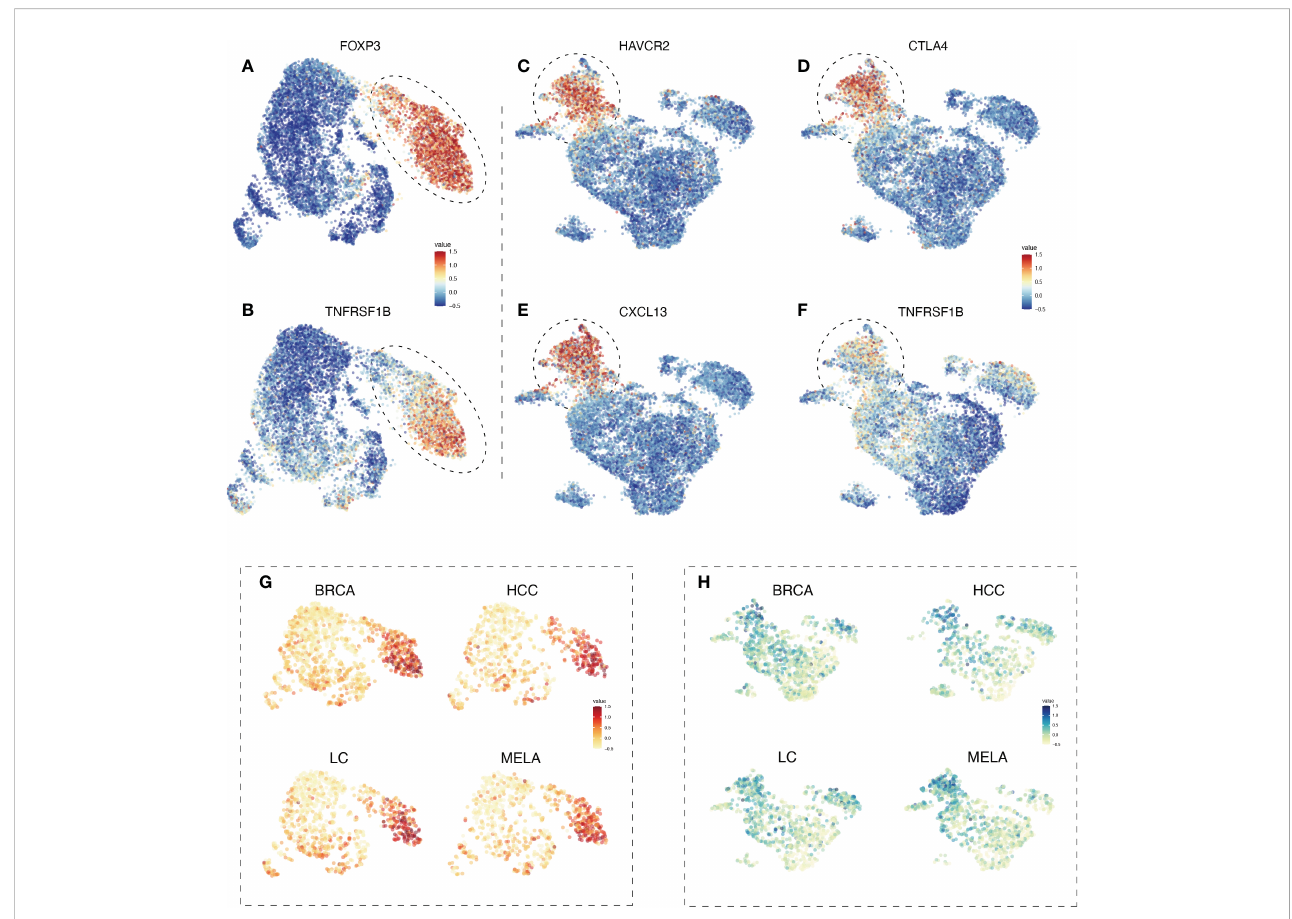
FIGURE 1 The expression pro fi le of TNFR2 in tumor-in fi ltrating Tregs and exhausted CD8 T cells in BRCA, HCC, LC, and MELA. To estimate the differentiation of TNFR2 expression among tumor-in fi ltrating immune cells, we re-analyzed and integrated the pan-cancer single-cell landscape from the Zemin Zhang group ’ s study, based on their framework of scDVA (short for single-cell RNA-seq data visualization and analysis). UMAP visualization shows the expression of FOXP3 (A) in CD4 T cell metaclusters. The dotted line represents regulatory T cells. (B) TNFR2 expression in CD4 T cell metaclusters. In CD8 T cell metaclusters, the expression of selected marker genes, such as HAVCR2 (C) , CTLA4 (D) , and CXCL13 (E) are shown. Dotted line represents terminal exhausted CD8 T cells. (F) TNFR2 expression in CD8 T cell metaclusters. UMAP visualization shows the expression of TNFR2 in CD4 T cell metaclusters (G) and CD8 T cell metaclusters (H) across four cancer types (BRCA, HCC, LC, and